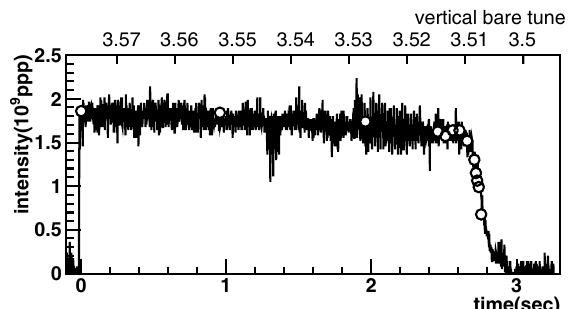
FIG. 3. Beam-loss behavior when the resonance line was crossed downward. The open circles show that the two- dimensional beam profiles were measured at those